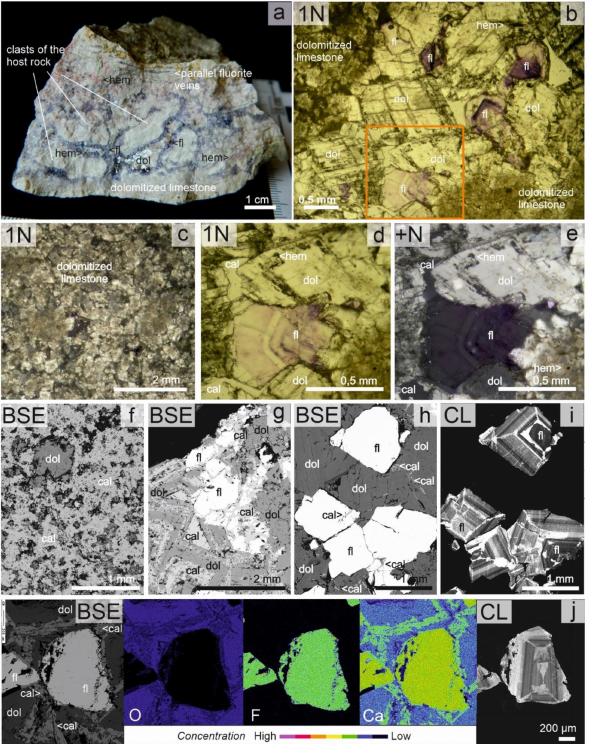
Figure 2. Mineralogy and petrography of the fluorite veins and their host rock. ( a ) Macroscopic picture of the contact of the fluorite–calcite–dolomite veins and host rock; ( b ) Microscopic picture of the fluorite–calcite–dolomite veins. The veins contain fluorite, dolomite, calcite, and hematite grains. The purple zonation of the fluorite grains is also visible. ( c ) Microscopic picture of the dolomitized limestone host rock; ( d ) microscopic image of the area indicated by an orange square in the picture b; ( e ) magnified microscopic image of the area indicated by an orange square in picture b. The isotropic fluorite crystals show optical anomaly (e.g., lack of full extinction) under crossed polarizers (+N) of the microscope; therefore, the zonation is visible; ( f ) BSE image of the host rock; ( g ) BSE image of fluorite and its environment. The complex dolomitization history of the vein is also visible. The fluorite grains are often fragmented, and calcite fills in the space between them; ( h ) BSE image of the vein-filling minerals; ( i ) SEM-cathodoluminescence (CL) picture of the fluorite grains and fragments; ( j ) BSE, element mapping and SEM-CL images of the same area. Abbreviations used: cal, calcite; dol, dolomite; fl, fluorite; hem,